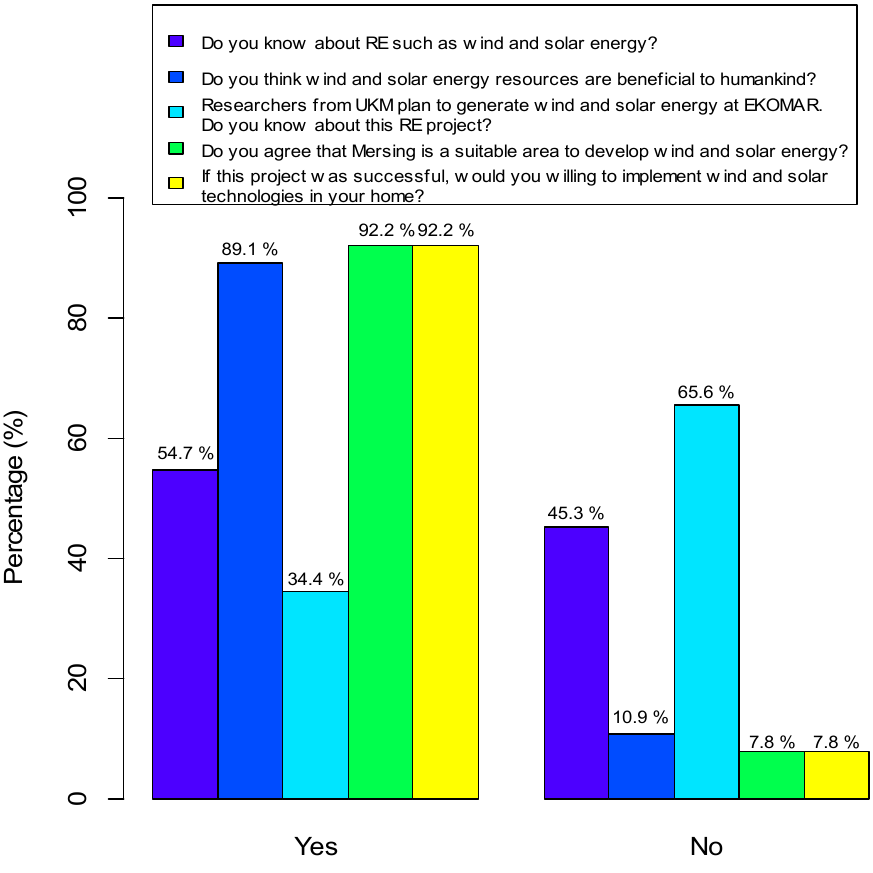
Figure 10. Respondents’ answers to “Yes” or “No” questions in Survey 1.